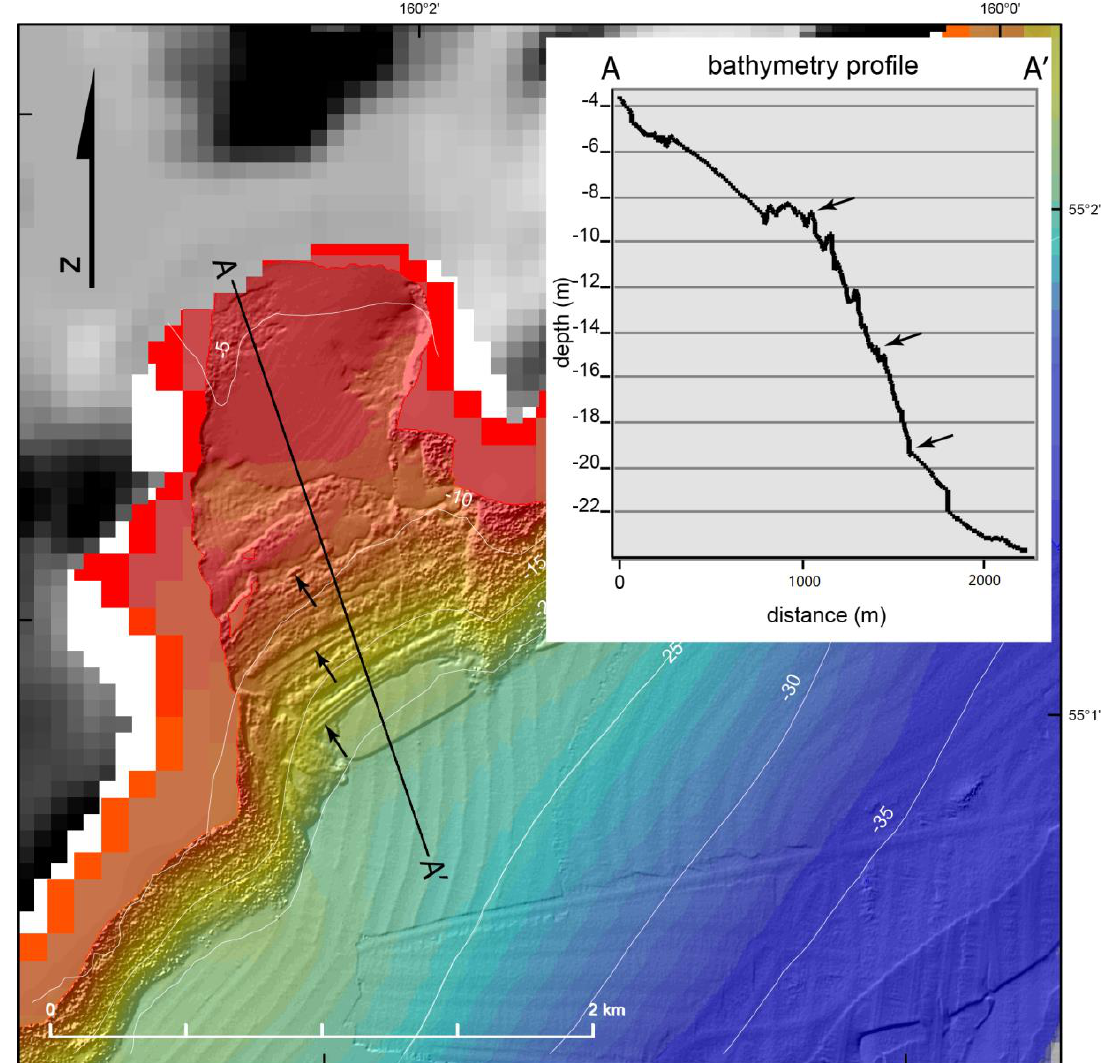
Figure 7. Submerged shorelines on southern Nagai Island. This unnamed bay lies to the southwest of Larsen Bay. The location of figure is shown on Figure 5, and the symbology is the same as Figure 5 but the color ramp is different, with the labelled contours indicating depth. Inset shows bathymetry profile with drowned shorelines between 19 m and 9 m below sea level. Elsewhere around the island, a continuous flight of shorelines extends up to 4 m below sea level.